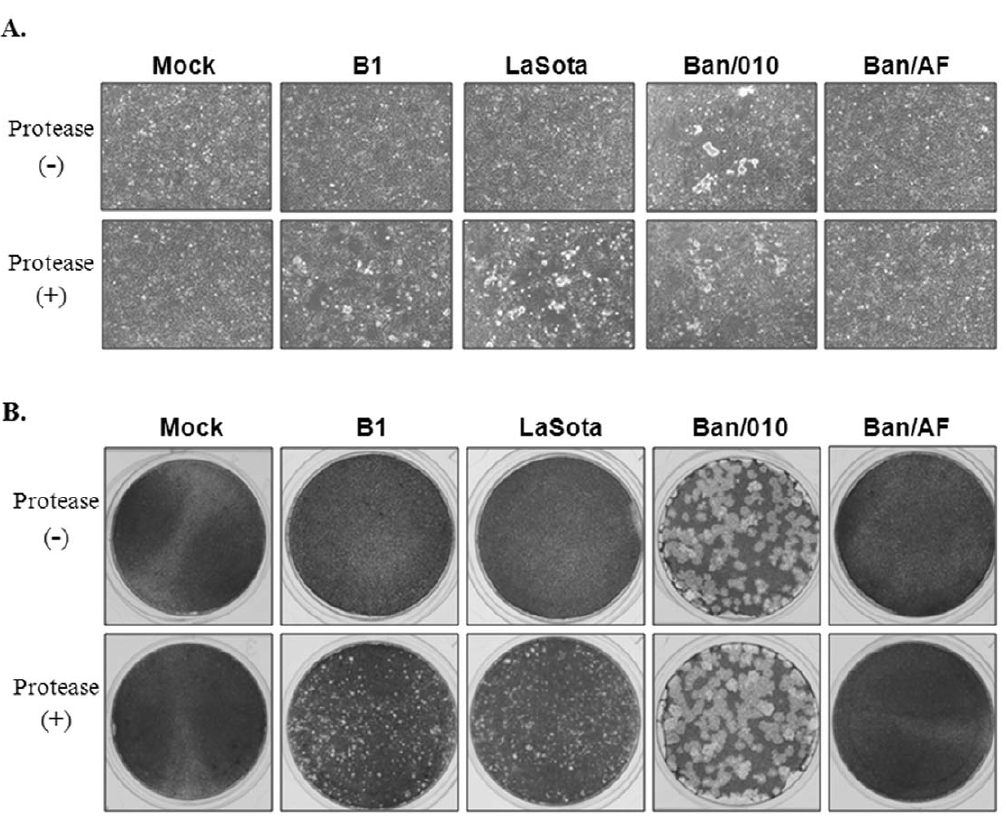
Figure 3. Syncytia and plaque formation by NDV strains in DF1 cells. (A) DF1 monolayers were infected with NDV strains B1, LaSota, Ban/010 and Ban/AF at an MOI of 0.01. The infected cells were cultured in the presence or absence of 10% normal allantoic fluids as exogenous protease. The cells were photographed at 36 hpi. (B) The cells were infected with the indicated viruses at an MOI of 0.01. The infected cells were overlaid by 0.8% methylcellulose DMEM and cultured in the presence or absence of 10% normal allantoic fluid for 7 days. The cells was fixed and stained with 1% crystal violet.